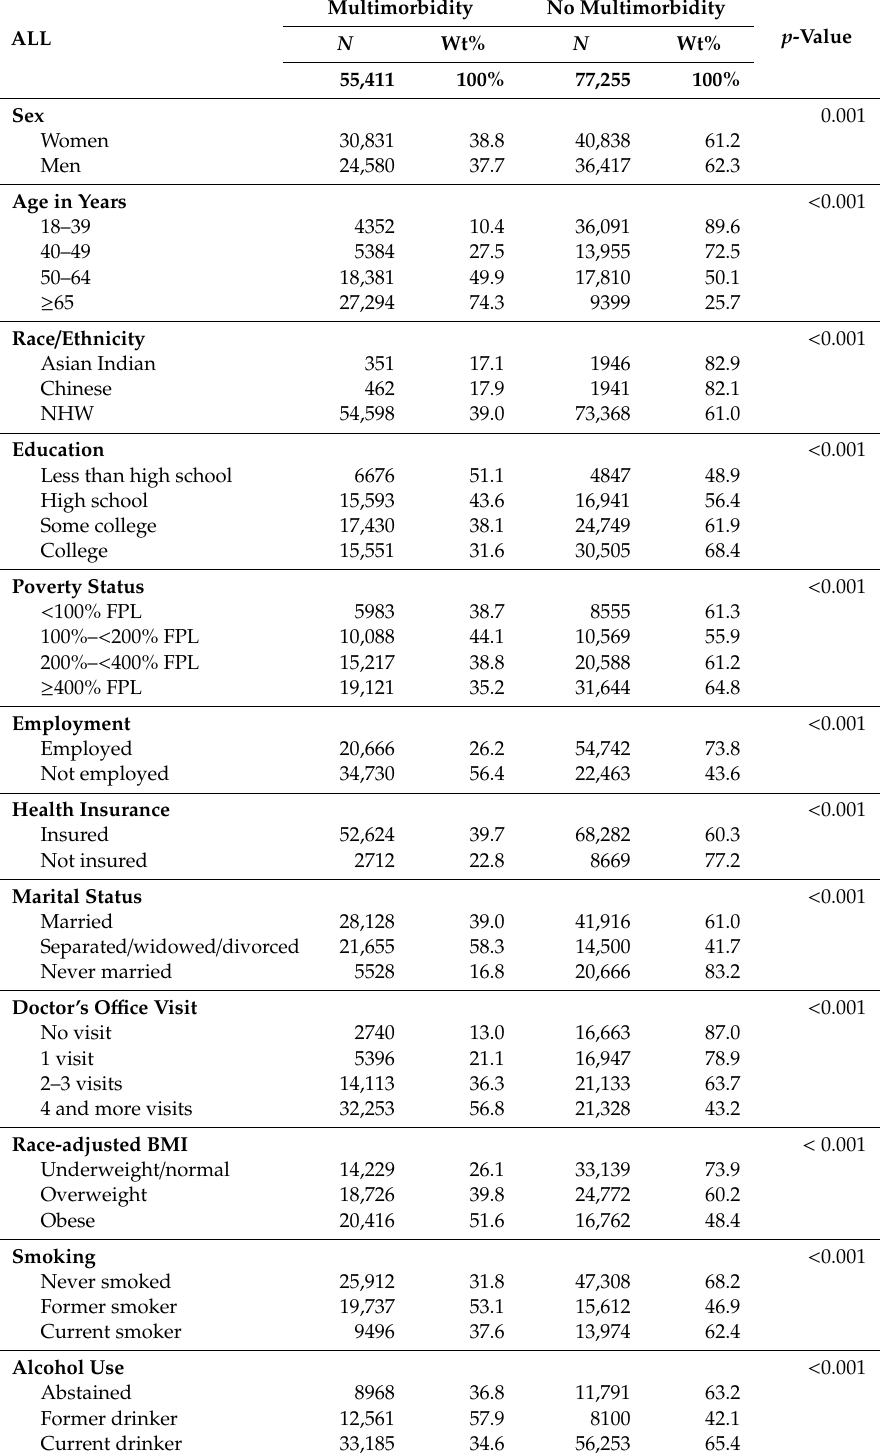
Table 2. Unweighted N and weighted % of Multimorbidity among Asian Indian, Chinese, Non-Hispanic White (NHW) adults (age ≥ 18 years). National Health Interview Survey,